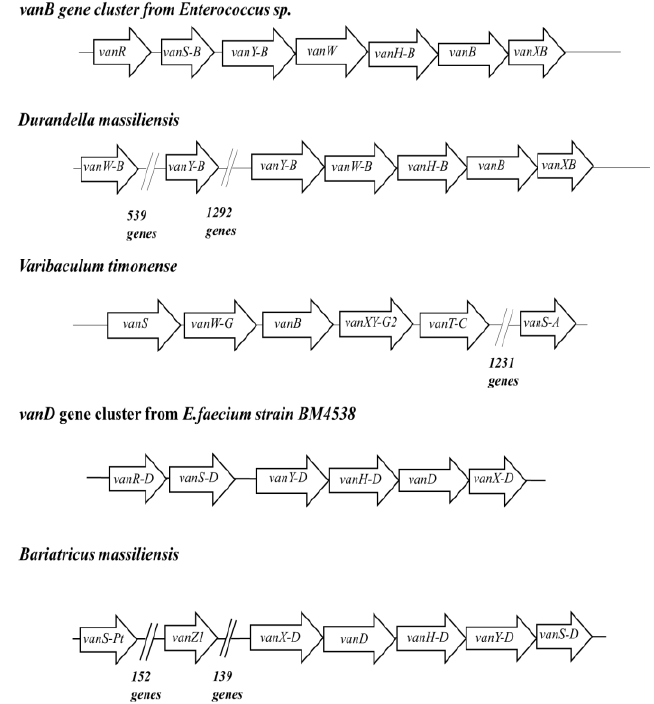
Figure 4. Schematic representation of the clusters of glycopeptide resistance genes found in three bacteria from the human gut in comparison with vanB and vanD gene clusters in Enteroccoccus sp.